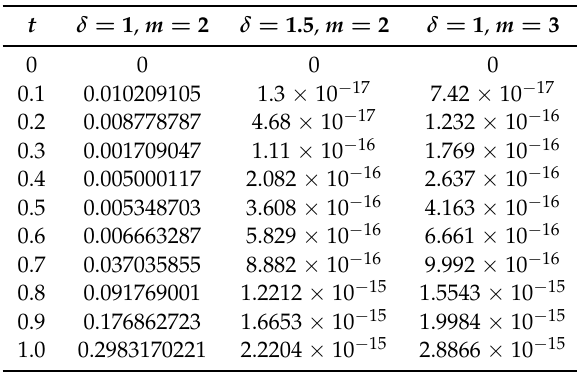
Table 2. The absolute errors with m = 2,